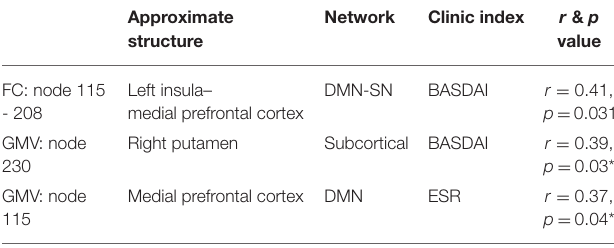
TABLE 4 | Secondary analysis: association with other clinic